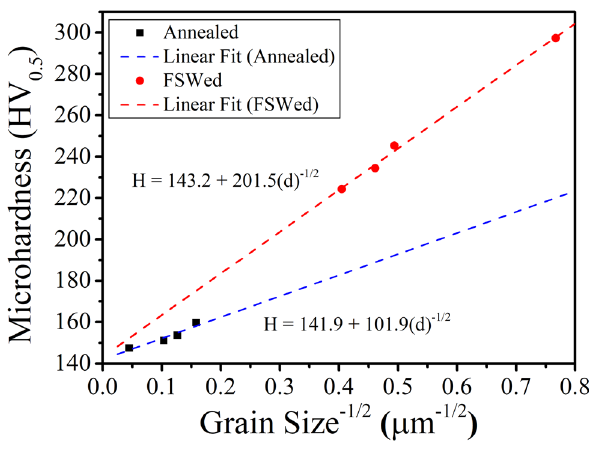
Figure 11: Hall – Petch relationship of the annealed and friction - stir - welded Al 0.3 CoCrCu 0.3 FeNi.